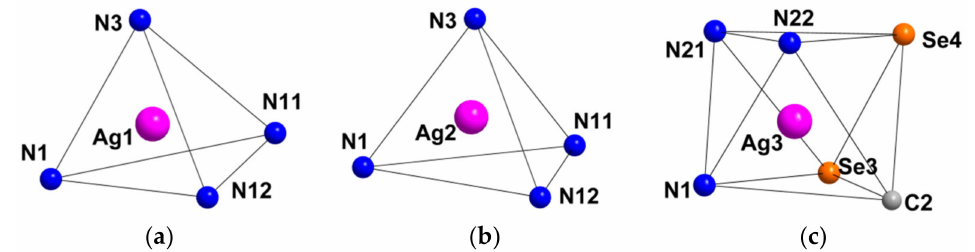
Figure 8. Coordination polyhedra of Ag1 ( a ), Ag2 ( b ) and Ag3 ( c )